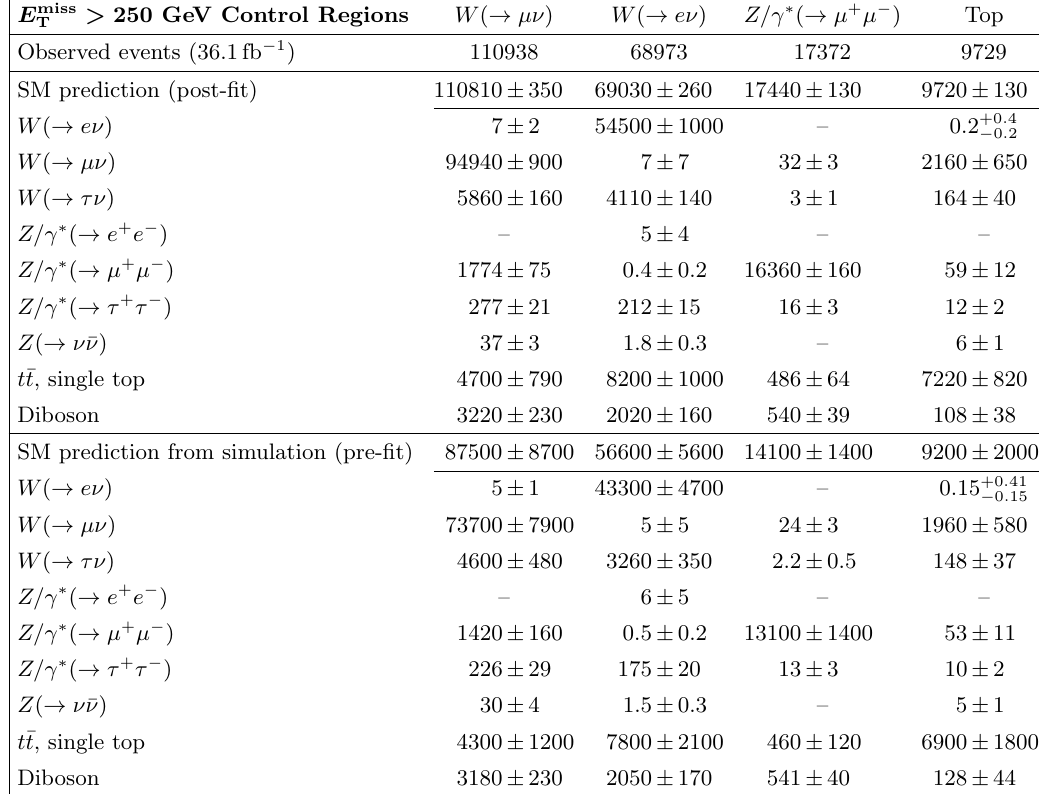
Table 2 . Data and background predictions in the control regions before and after the (cid:12)t is per- formed for the E miss